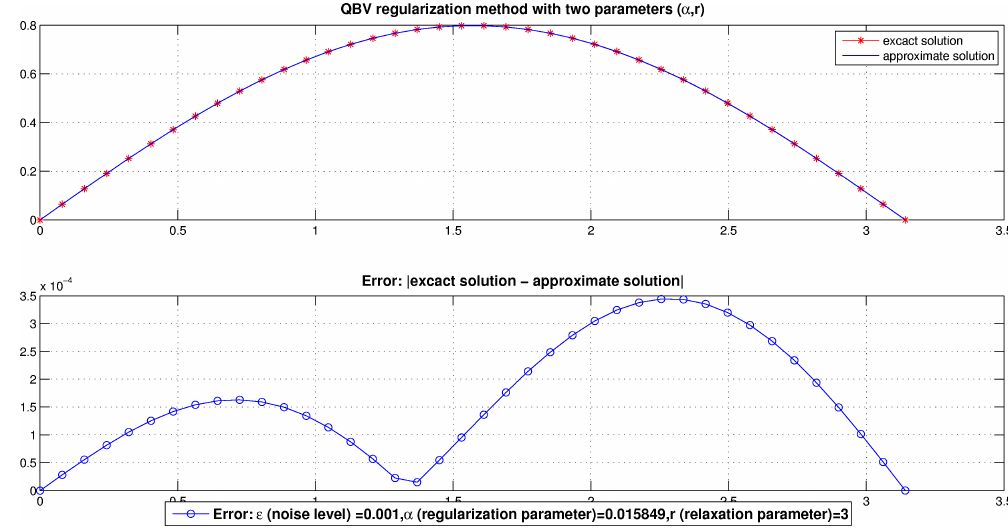
Fig. 4. ε (noise level) =0.001, α (regularization parameter)=0.015849, r (relaxation parameter)=3